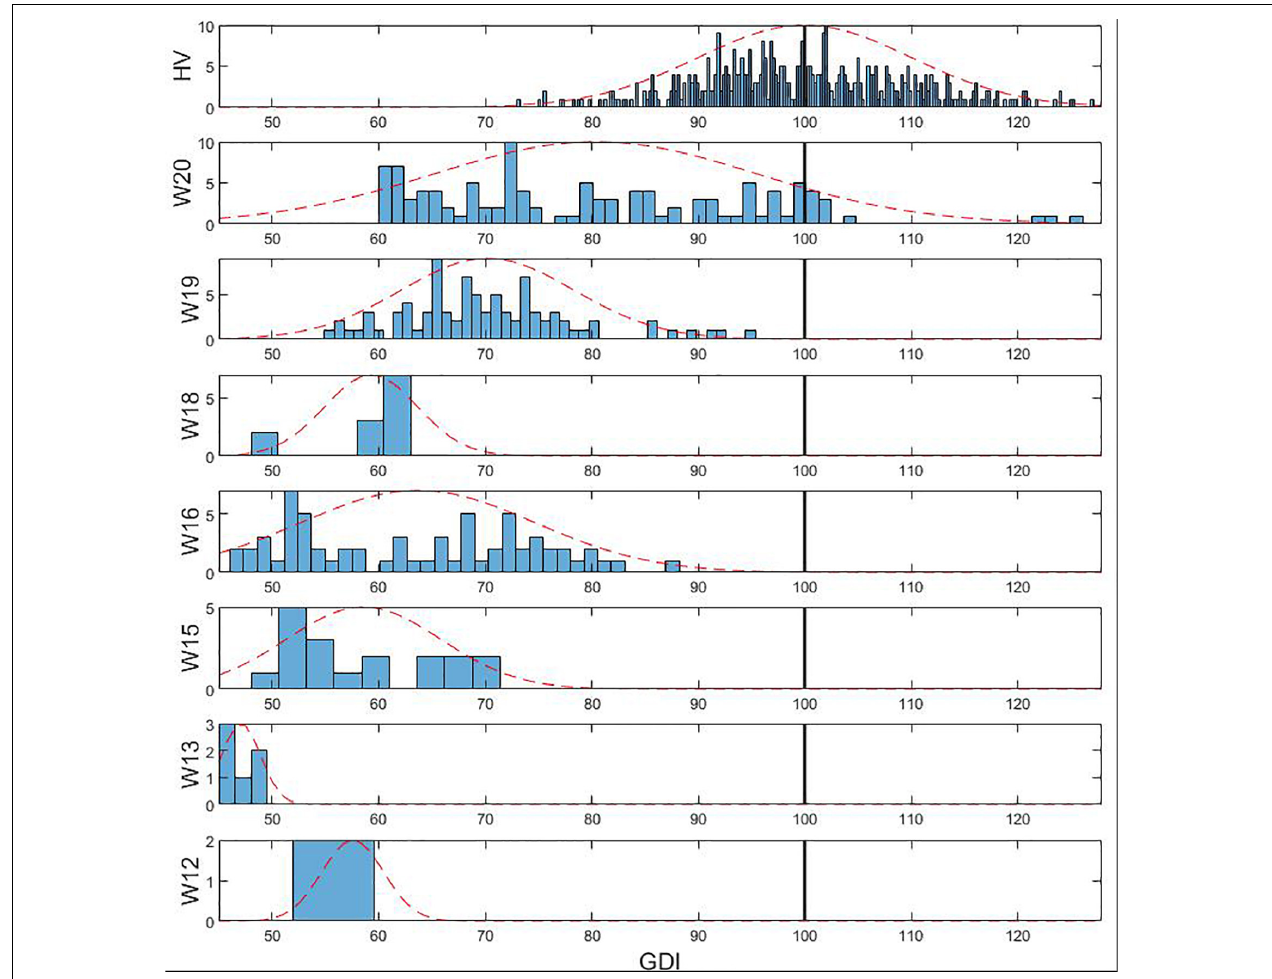
FIGURE 2 | Histograms of GDI values stratified by WISCI II levels in population with iSCI. The dotted line represents the normal distribution curve fitted to the data wihtin each WISCI II level. The vertical black line indicates the HV